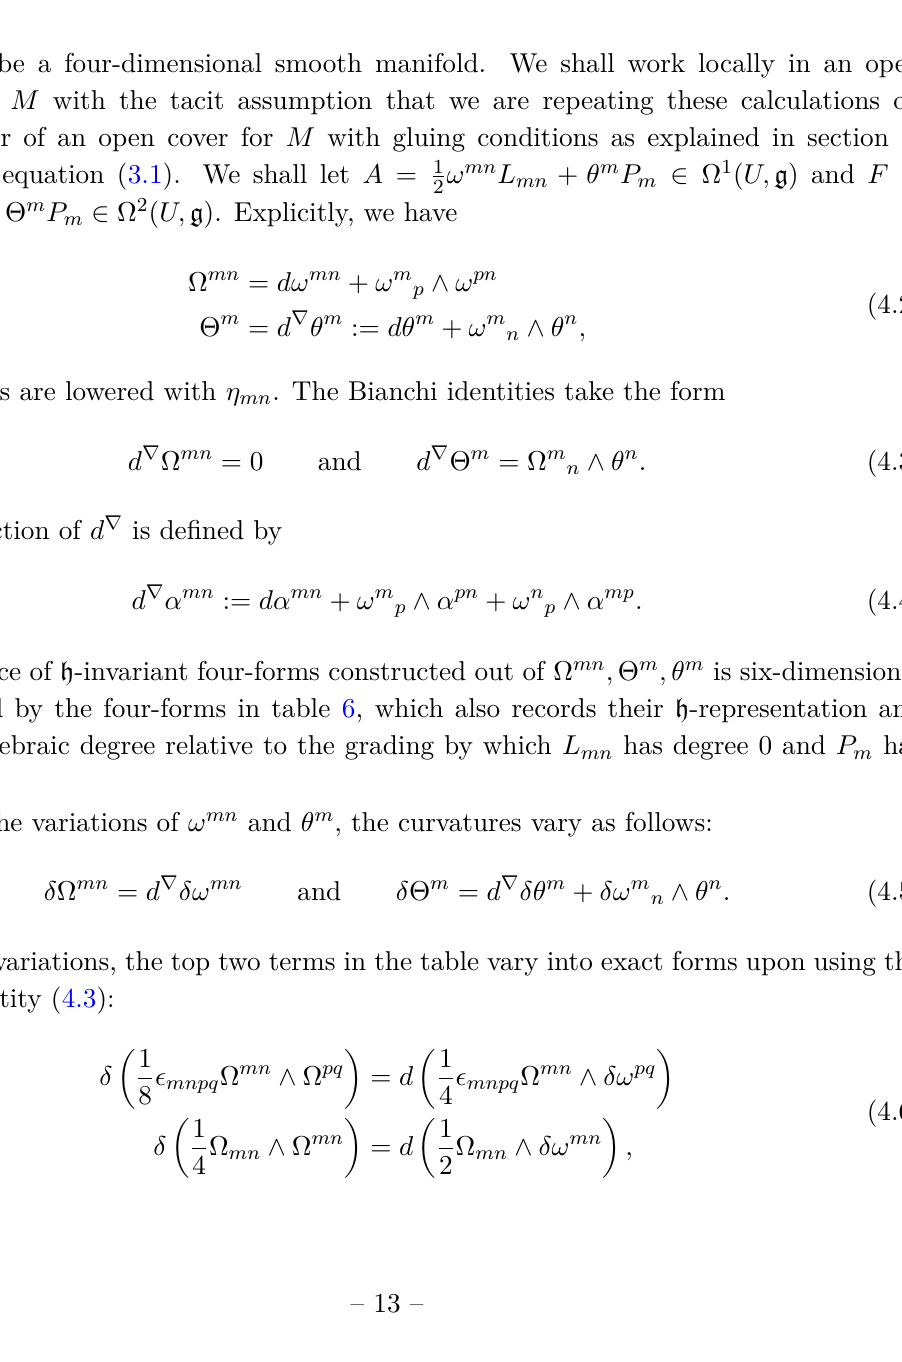
Table 6 . Gauge-invariant 4